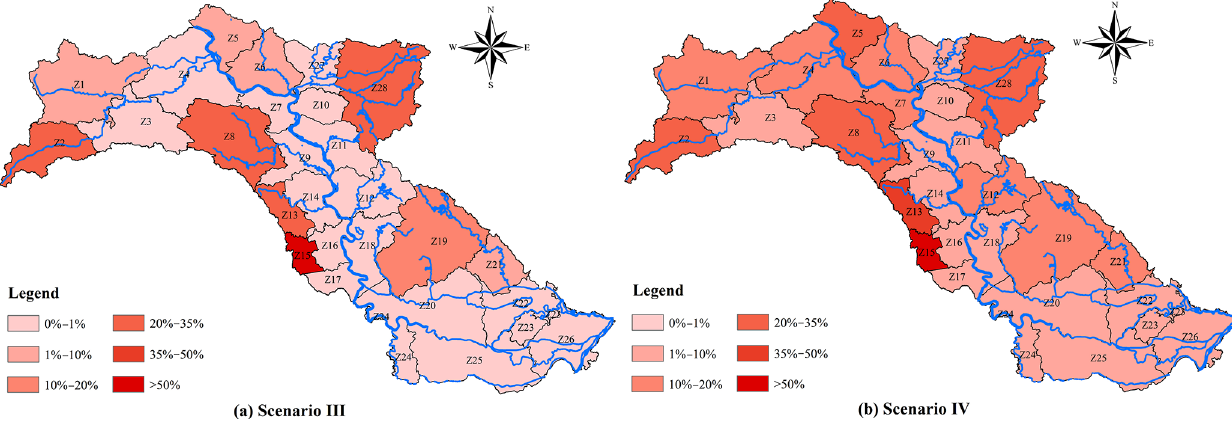
Figure 7. Distribution of water shortage